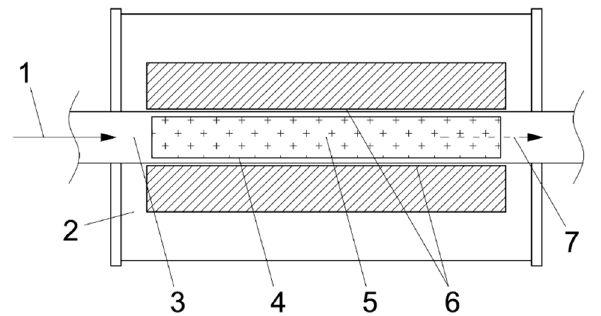
Figure 2. Scheme of the process activation installation: 1—incoming liquid flow for processing; 2—cooling jacket housing; 3—working area; 4—replaceable insert; 5—working bodies—ferromagnets (needles); 6—induction coils; 7—processed stream.